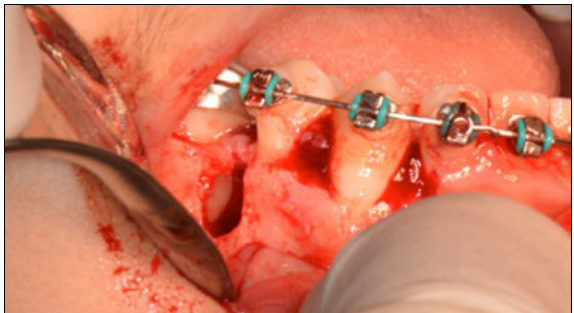
Figure 8. Intra-operative view of lesion.